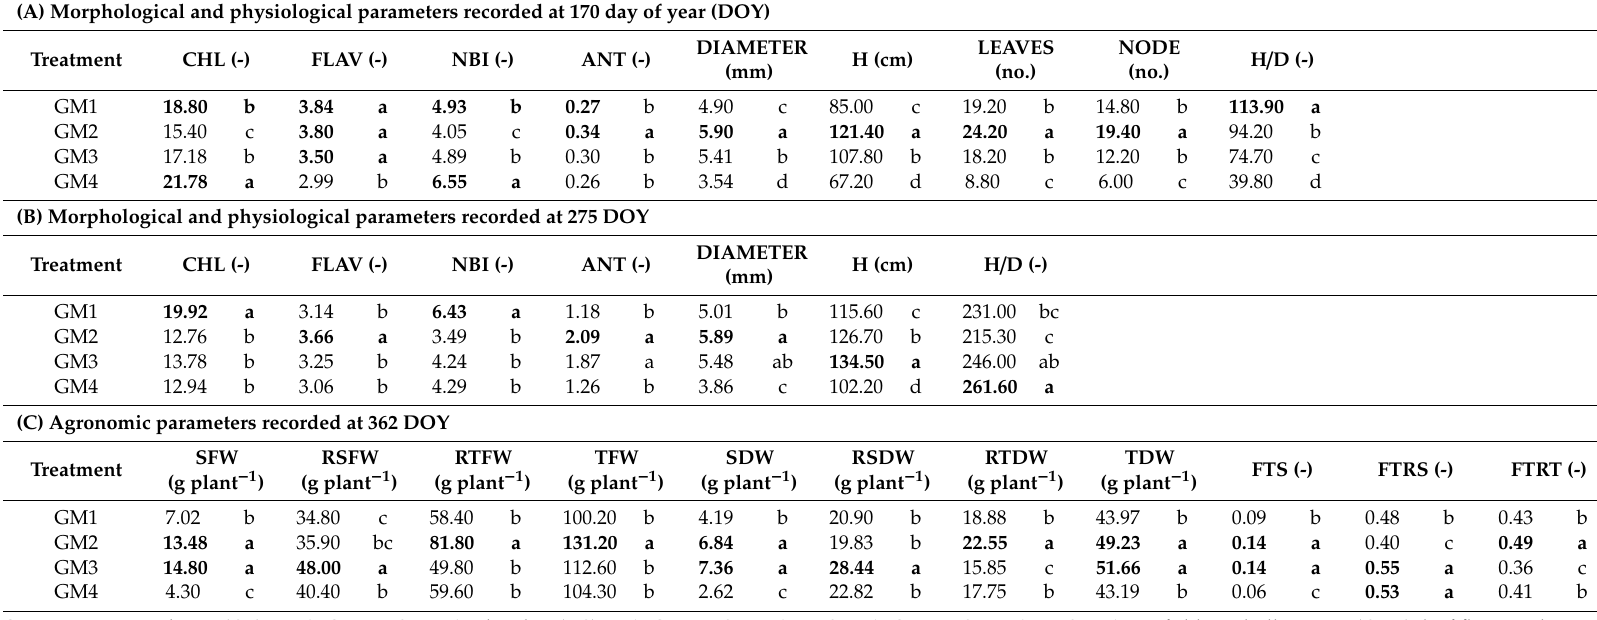
Table 7. Parameters recorded on bare-rooted vines grown on growing media containing